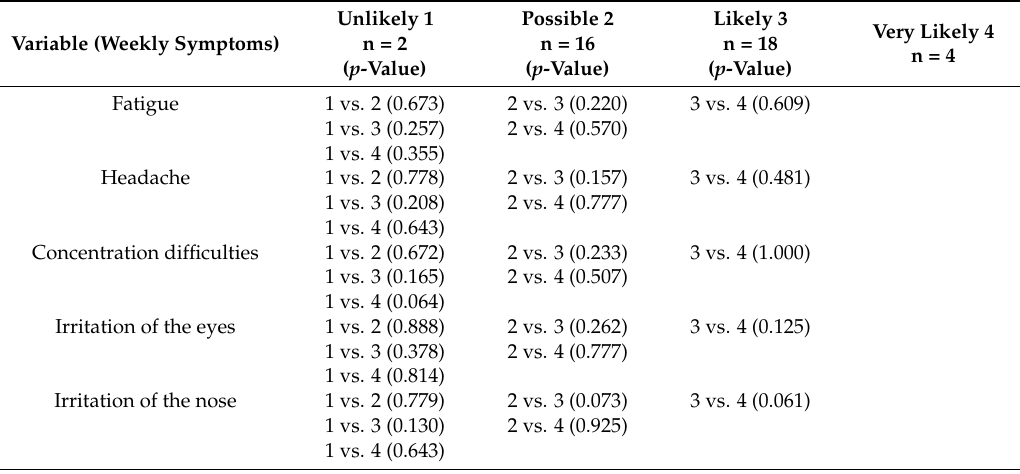
Figure 3. Perceived work environment-related symptoms of users of premises in assessment of probability of abnormal IA exposure categories, compared to FIOH reference data [28] ( a ) unlikely (n = 61), ( b ) possible (n = 618), ( c ) likely (n = 760), ( d ) very likely (n = 118). Table 3. An analysis of the differences between the probability of abnormal IA exposure categories (unlikely, possible, likely, very likely) and the employees’ weekly perceived work environment-related symptoms.